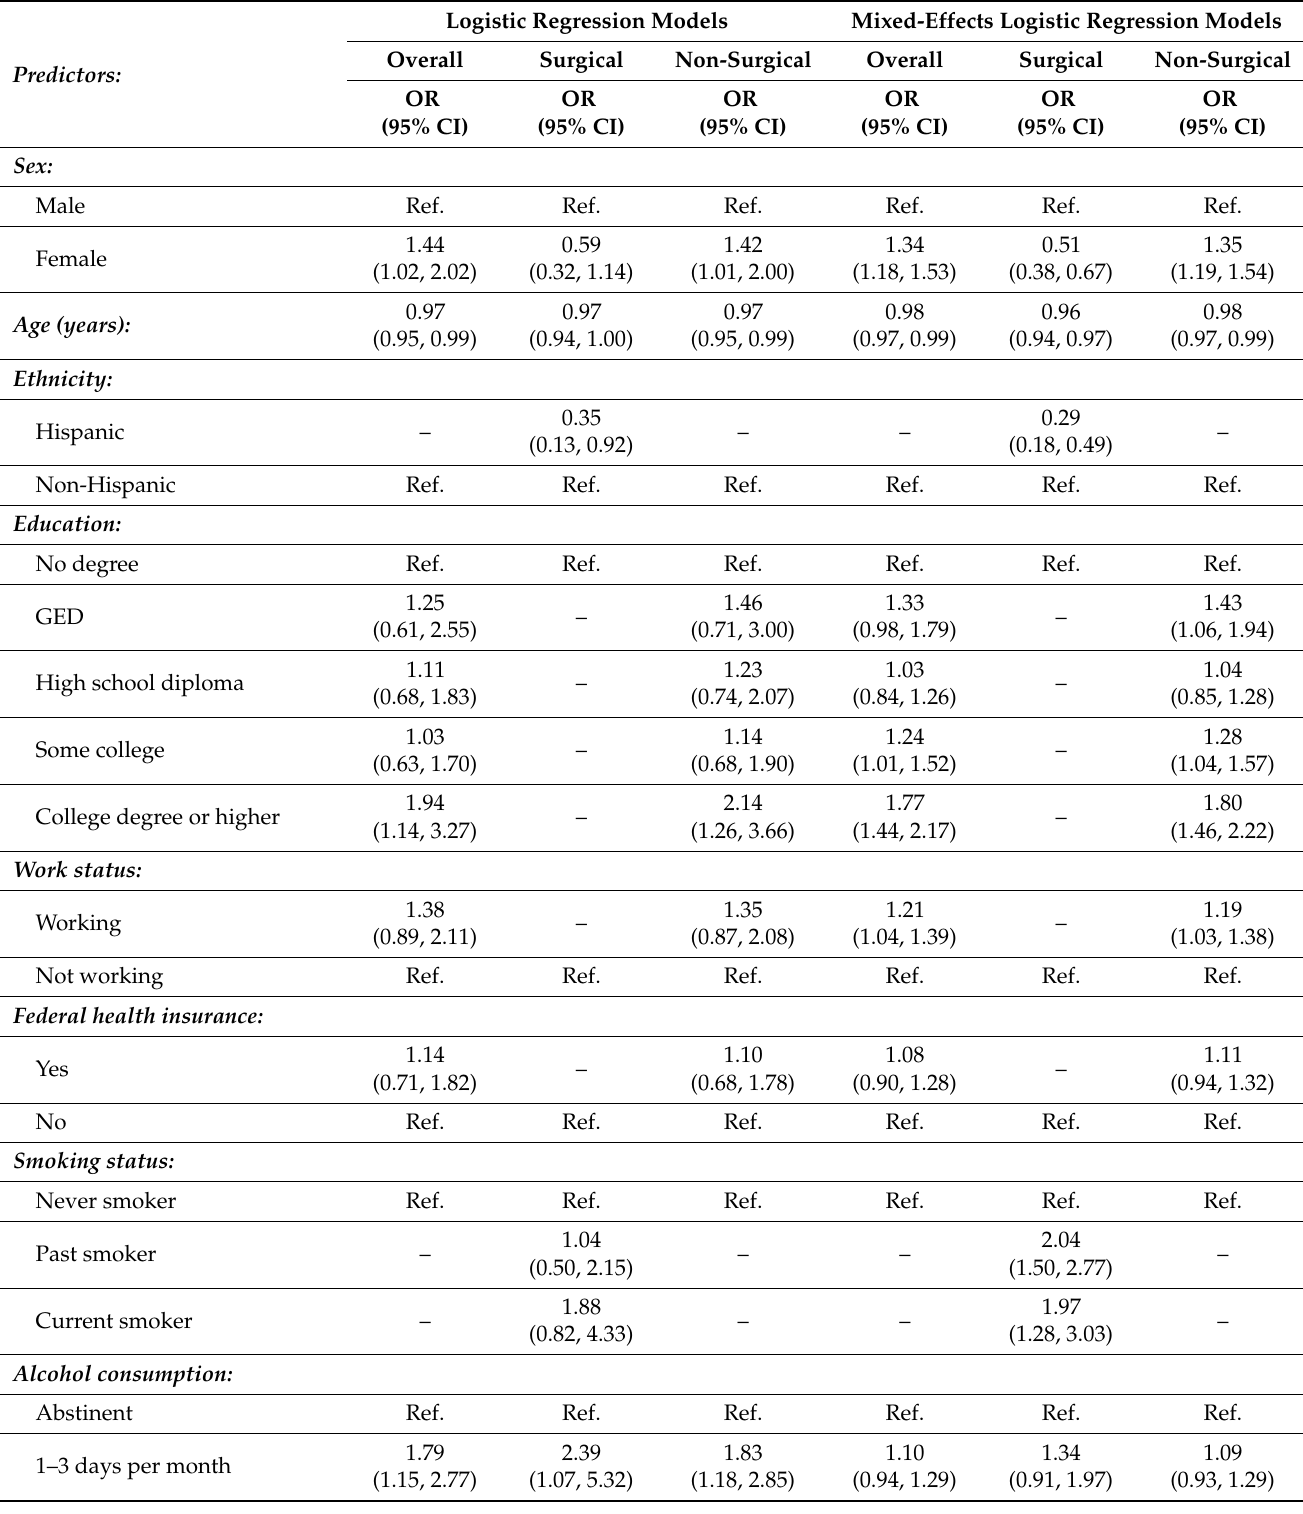
Table 5. Logistic regression models for key predictors of delayed healthcare–HRS COVID-19 half- sample a